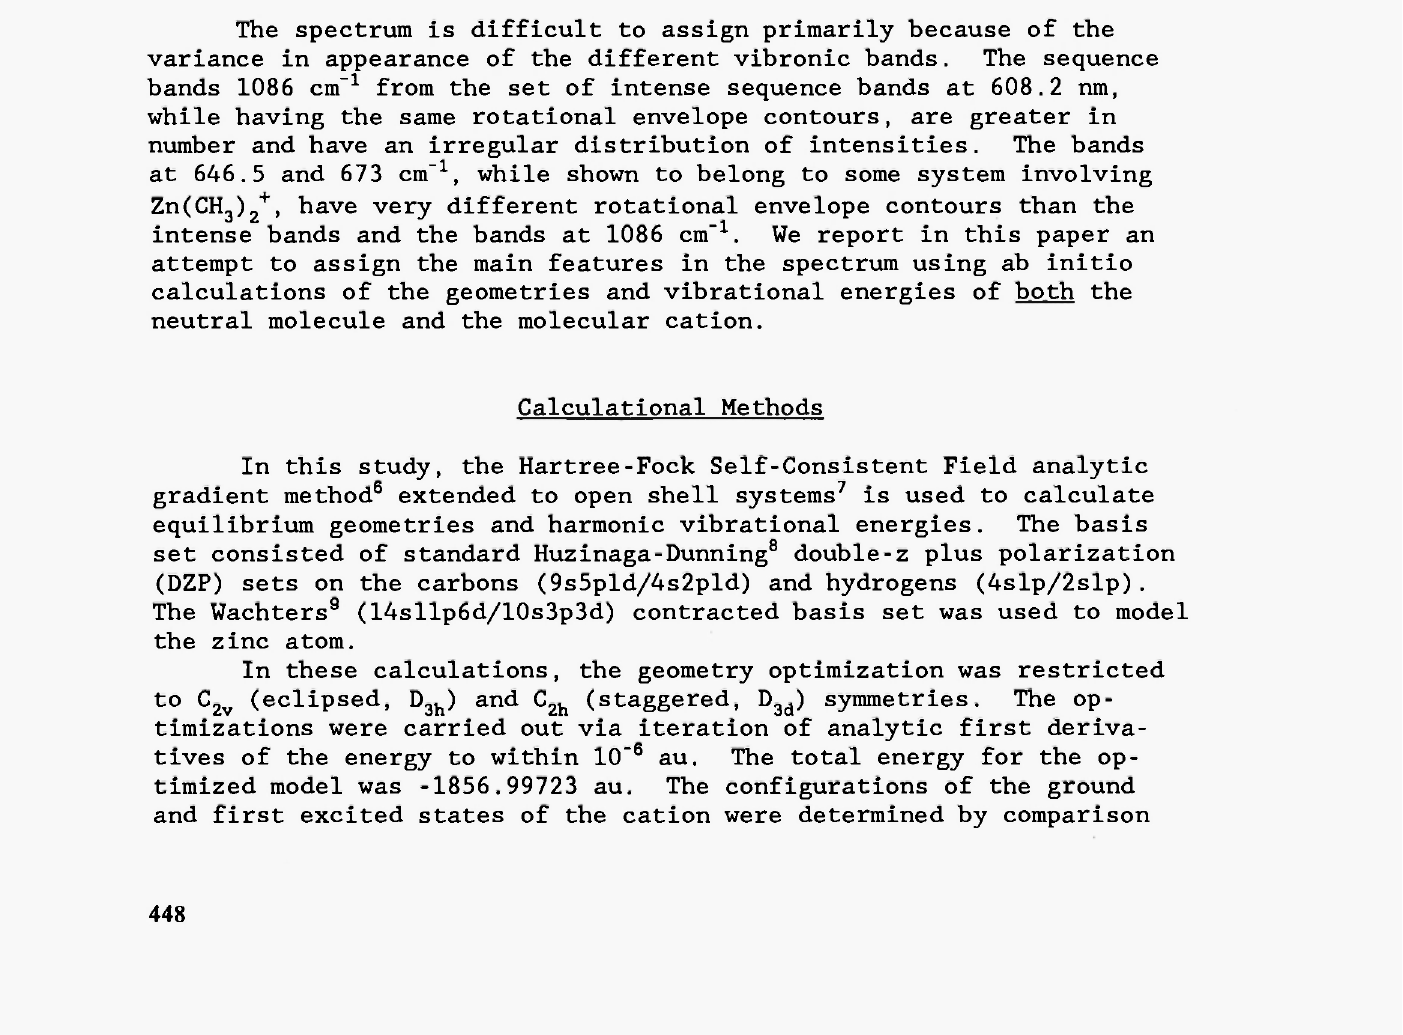
Figure 1. Electronic spectrum of ZniCHj)^ produced by electron impact of a free-jet